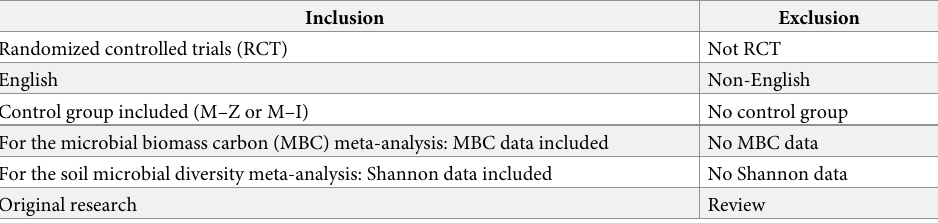
Table 1. Inclusion and exclusion